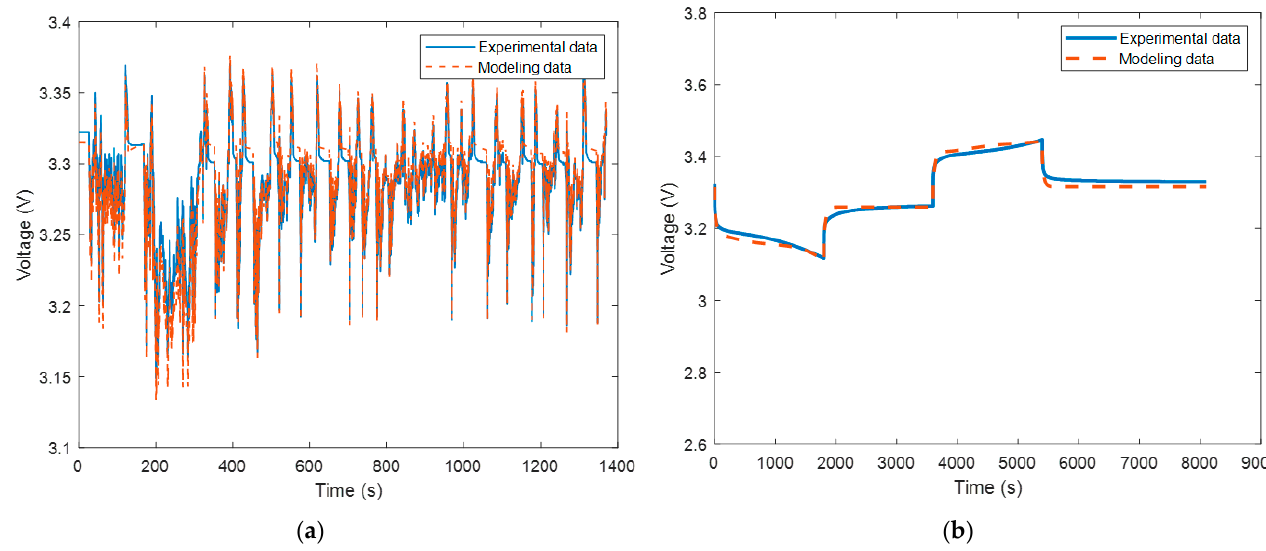
Figure 7. Model validation results from the LFP cell using first-order ECM at 0.6 SOC: ( a ) UDDS cycle, and ( b ) ND cycle.